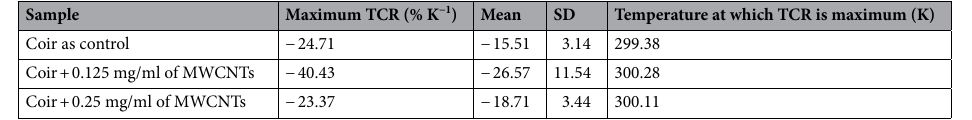
Table 2. Shows the temperature at which the maximum TCR is obtained in each of the